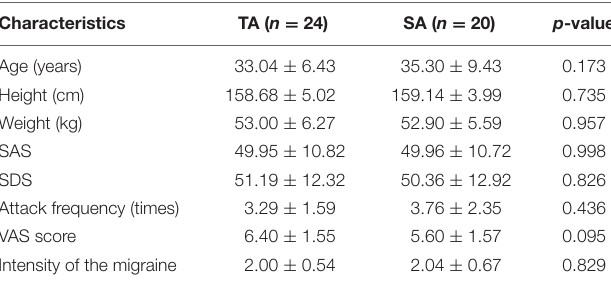
TABLE 3 | Baseline characteristics of the patients.